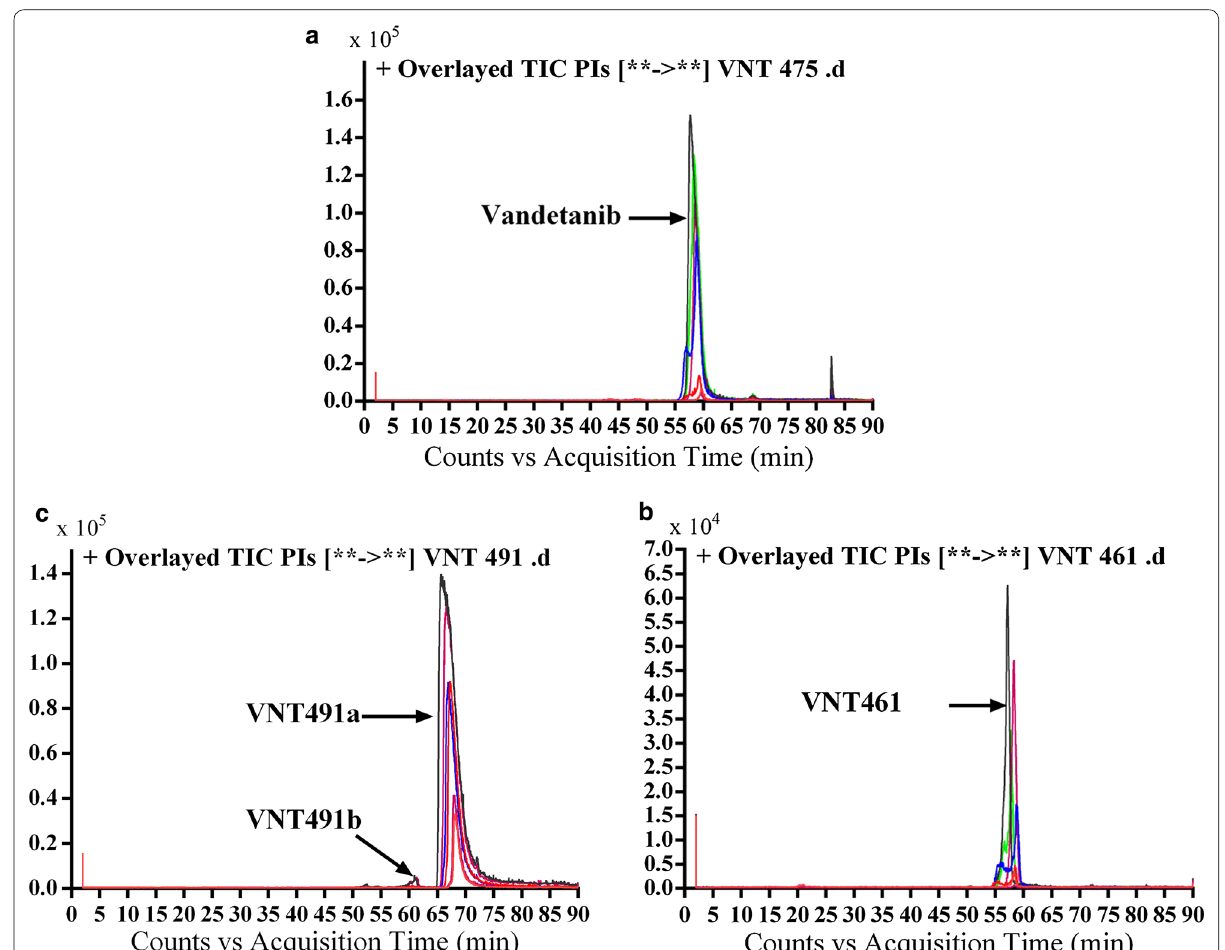
Fig. 8 Overlayed PI chromatograms of vandetanib (58.3 min) and VC475 (68.6 min) ( a ), VC461 (57.2 min) ( b ) and VC491a (56.5 min) and VC491b (67.0 min) ( c )